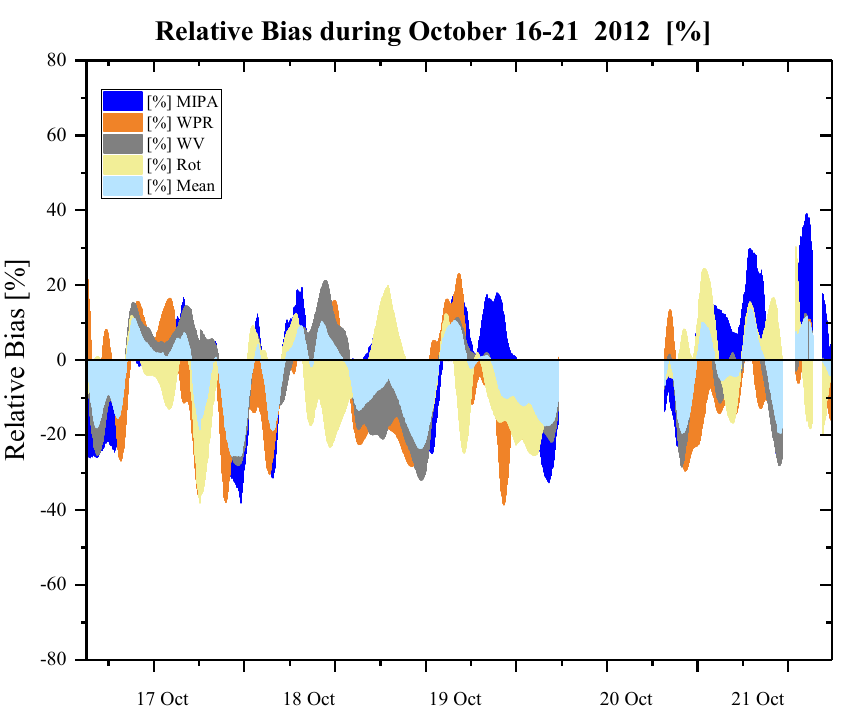
Figure 3. Relative biases (%) of the ABLH estimates obtained by the compared methods with respect to reference data during the period 16–21 October 2012.